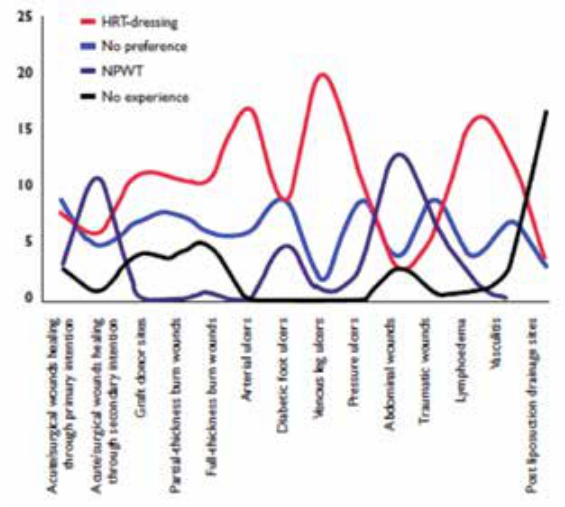
Figure 1: Treatment preference for HRT-dressing (Sorbion) in respect of a range of wound